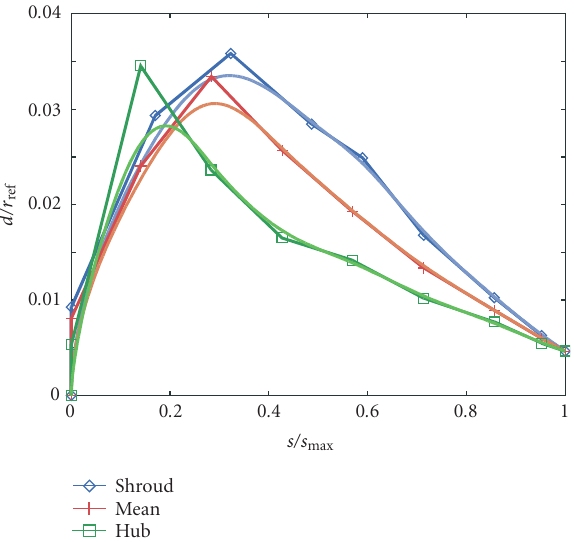
Figure 1: B-spline representation of a camber surface. Figure 2: Thickness distribution along three surfaces of revolution.